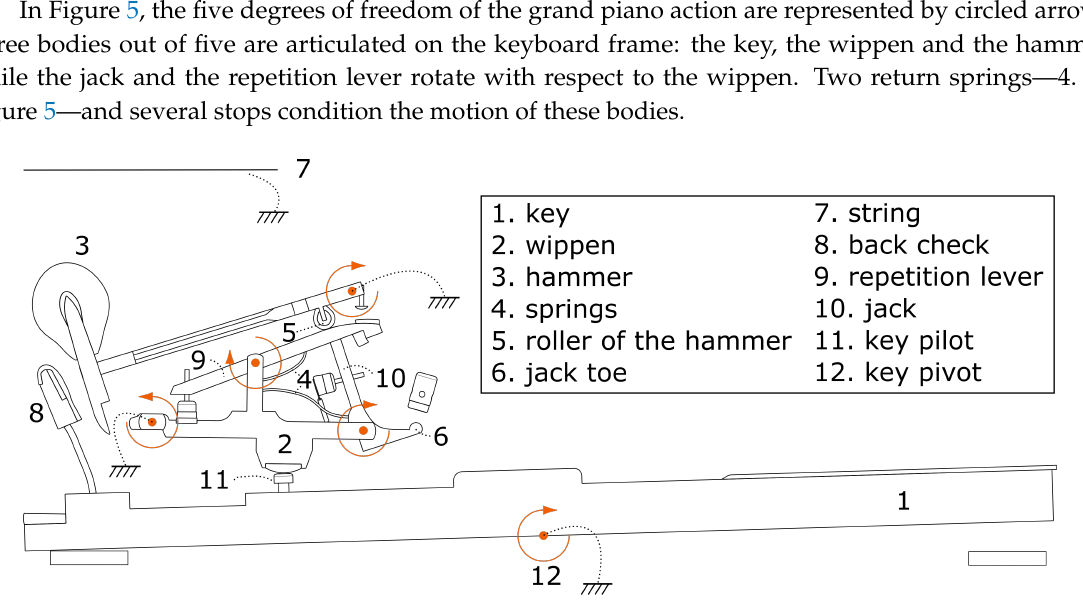
Figure 5. Multibody model elements for a double escapement piano action: bodies, joints, stops,